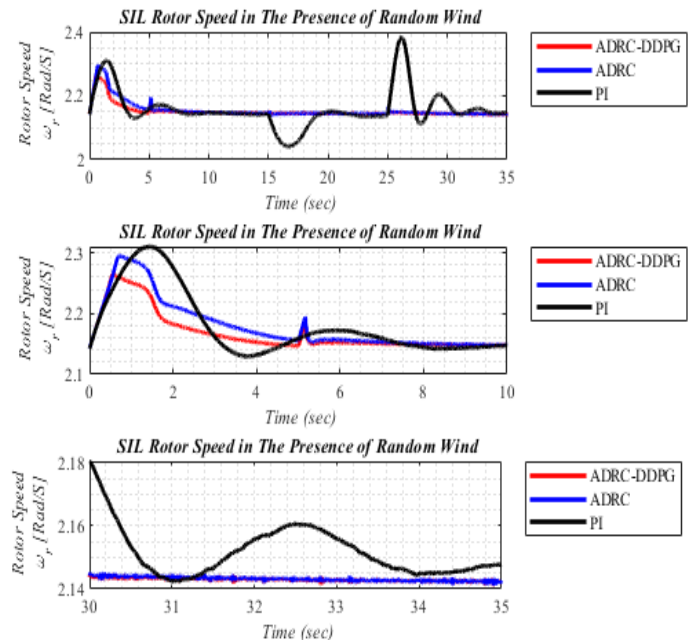
Figure 15. SIL output comparative results of ADRC-DDPG, ADRC and PI controllers according to scenario II.